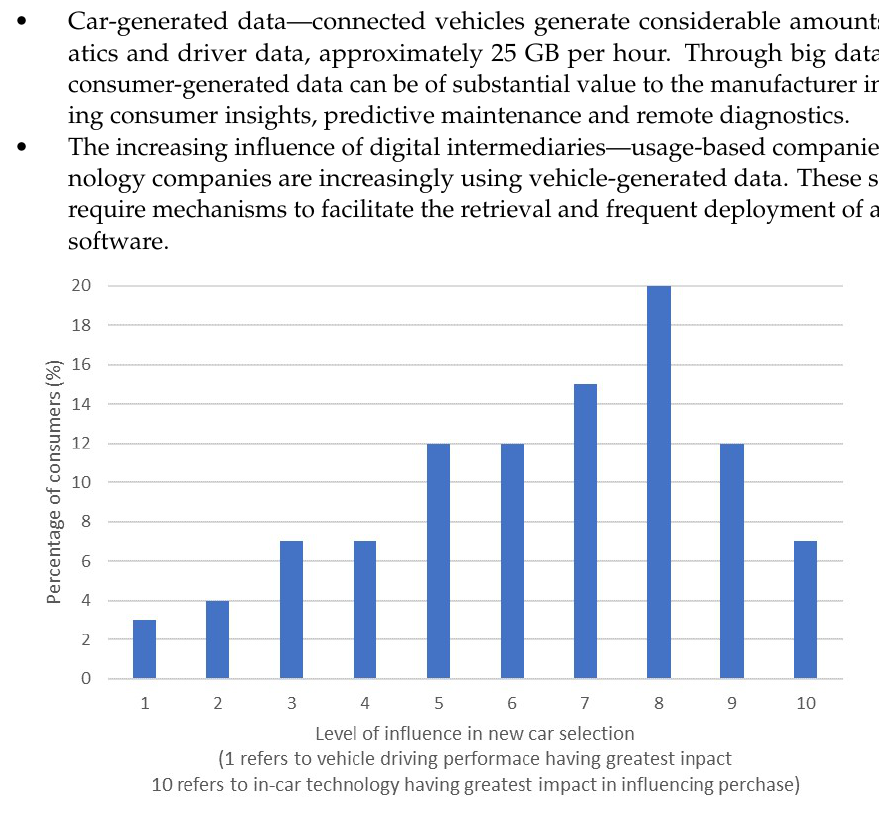
Figure 2. Consumer Preference: New Car